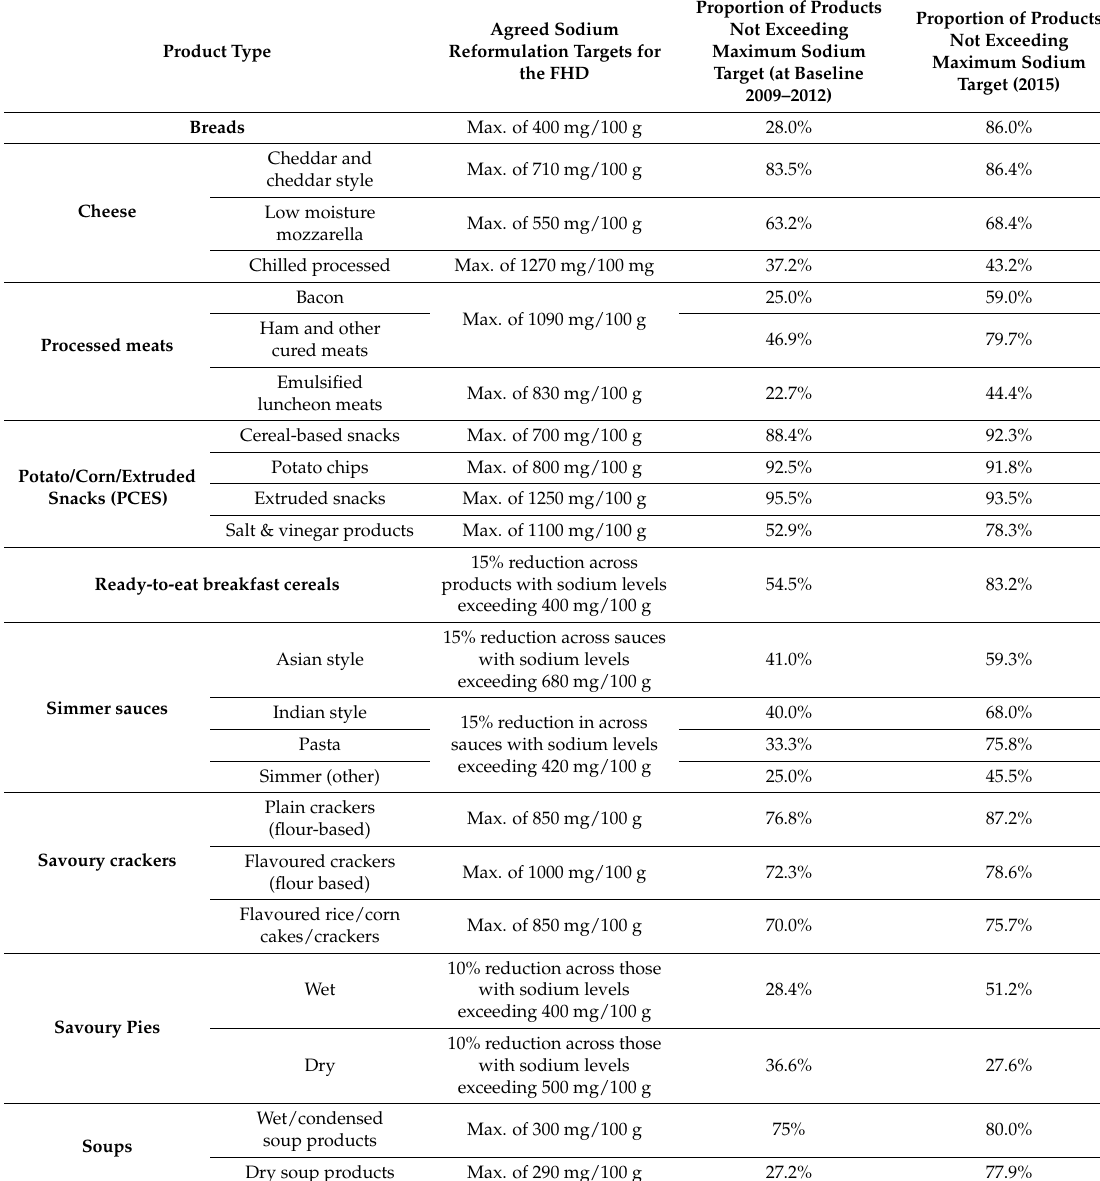
Table 2. An evaluation of the FHD reformulation targets, adapted from [25]. Reproduced with permission from authors and